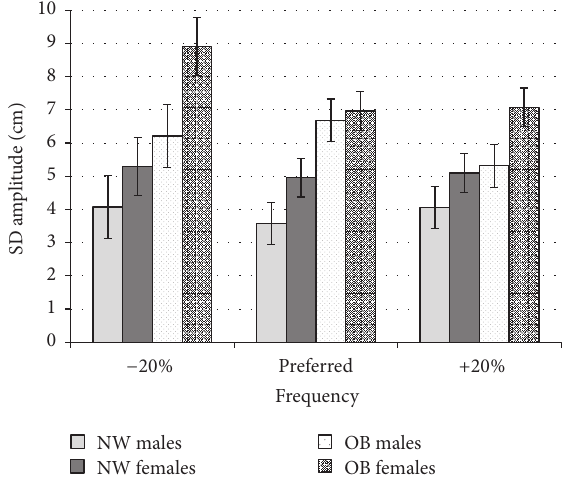
Figure 5: Mean standard deviation of amplitude shown for normal weight (NW), and obese (OB) participants divided by gender for all 3 frequency conditions ( − 20%, preferred frequency, and +20%). Greater values imply a greater degree of variability in the amplitude over which participant